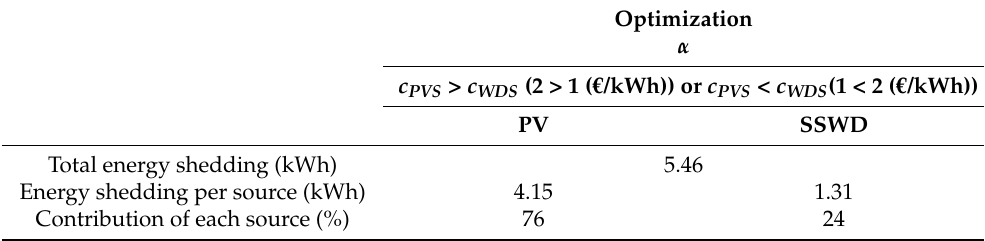
Figure 13. The PV and SSWD shedding curves by applying the α coefficient in the case of optimization. Table 5. Energy shedding calculation for the α coefficient in the case of